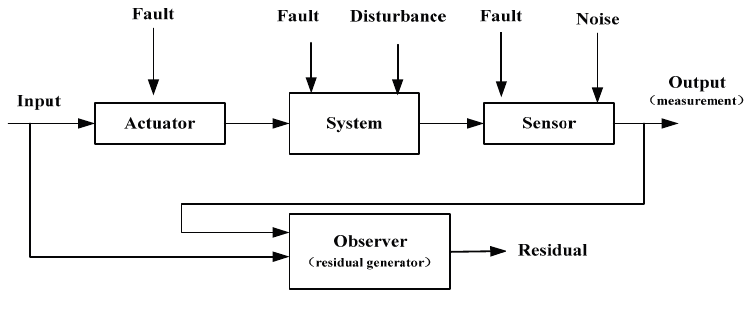
Figure 1. The negative influence of the